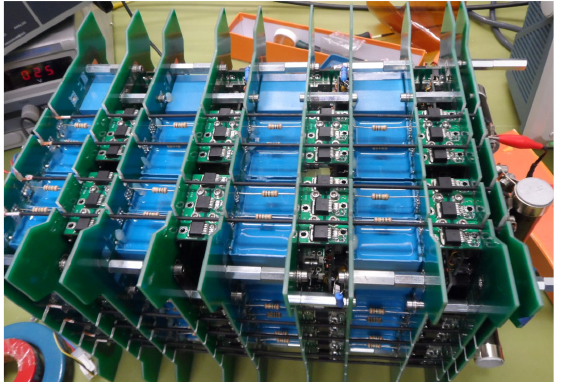
FIG. 9. Four-stage Marx generator assembled in a coaxial structure (four insulated return conductors per